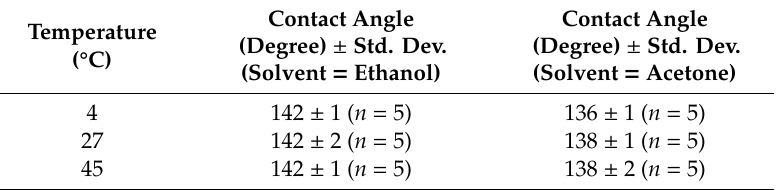
Table 4. Temperature e ff ect on the film contact angles using ethanol or acetone within 28